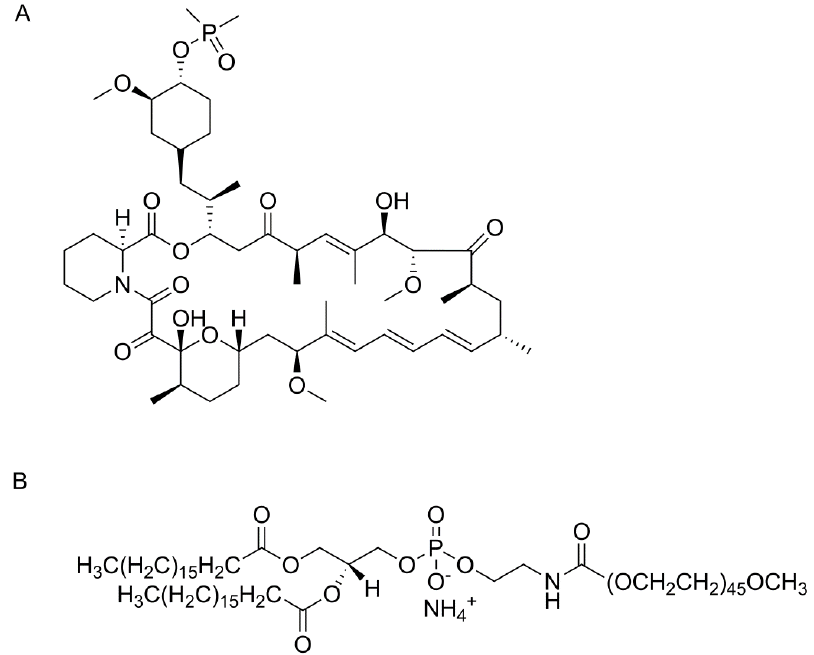
Figure 1. Chemical structure of ( A ) ridaforolimus and ( B ) DSPE-PEG